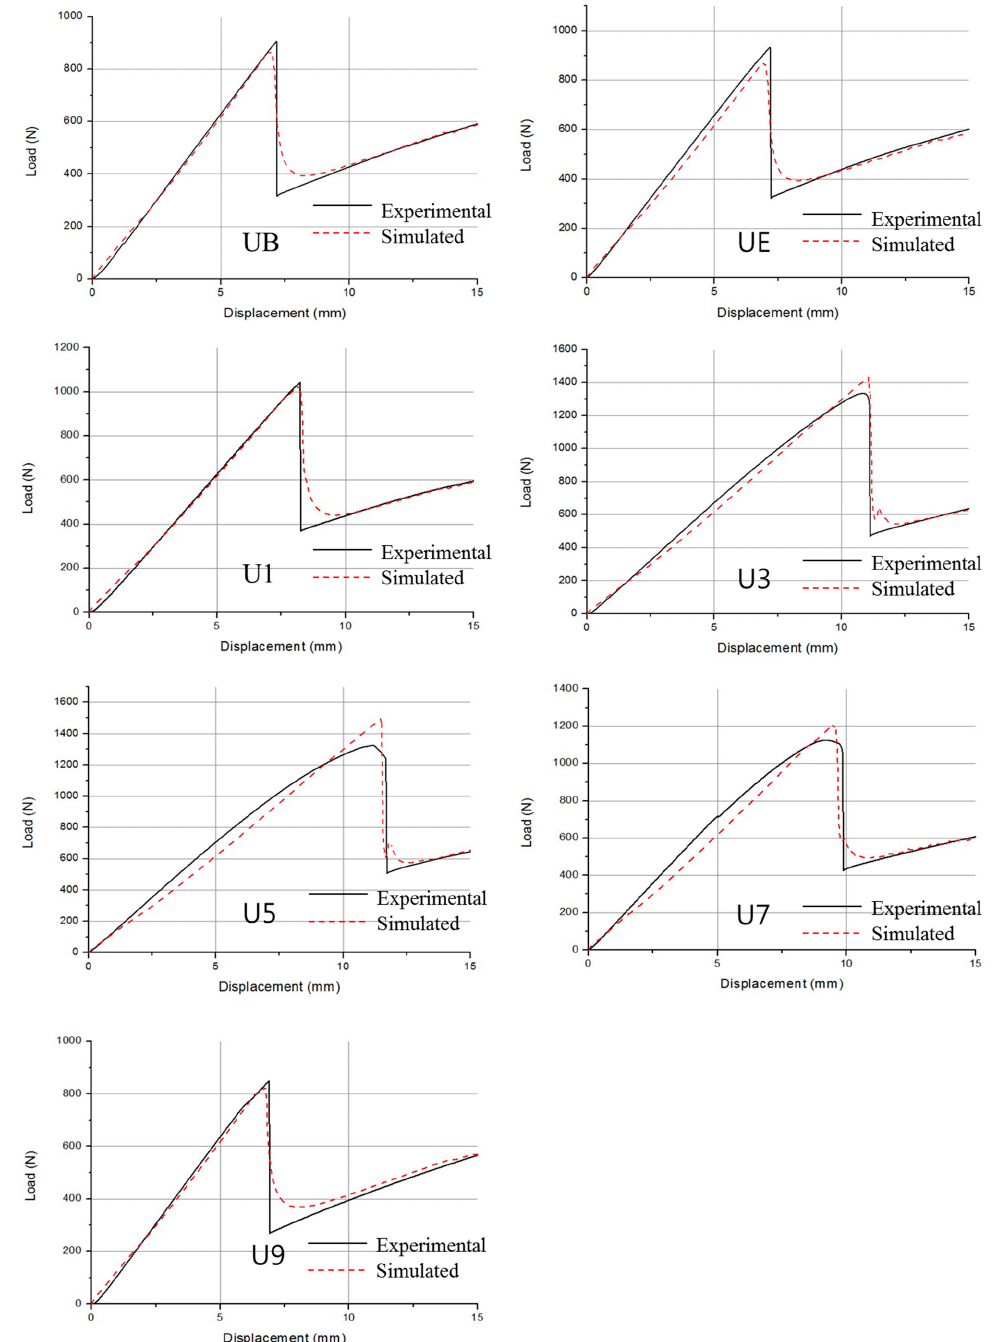
Figure 5. Experimental and simulation results with divided cohesive zone (UD).